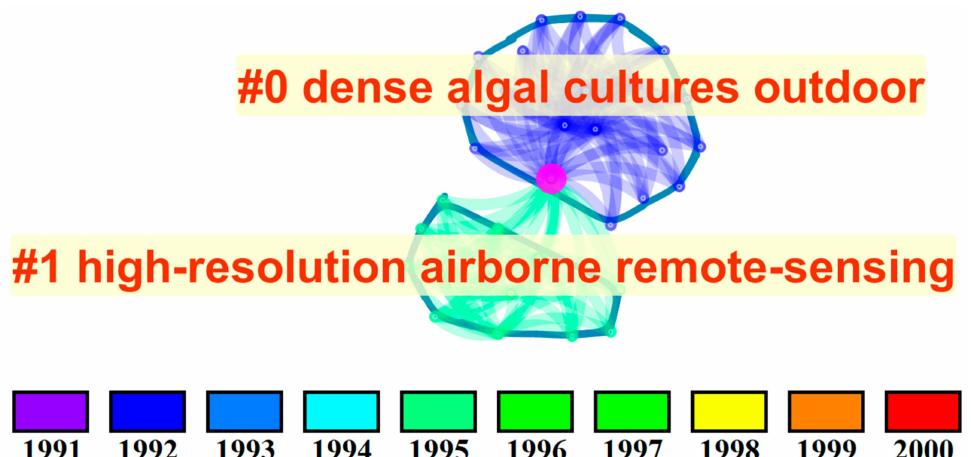
Figure 4. The co-citation network of remote sensing of PC publications clusters (1991-2000) and clusters’ labels extracted by LLR method.